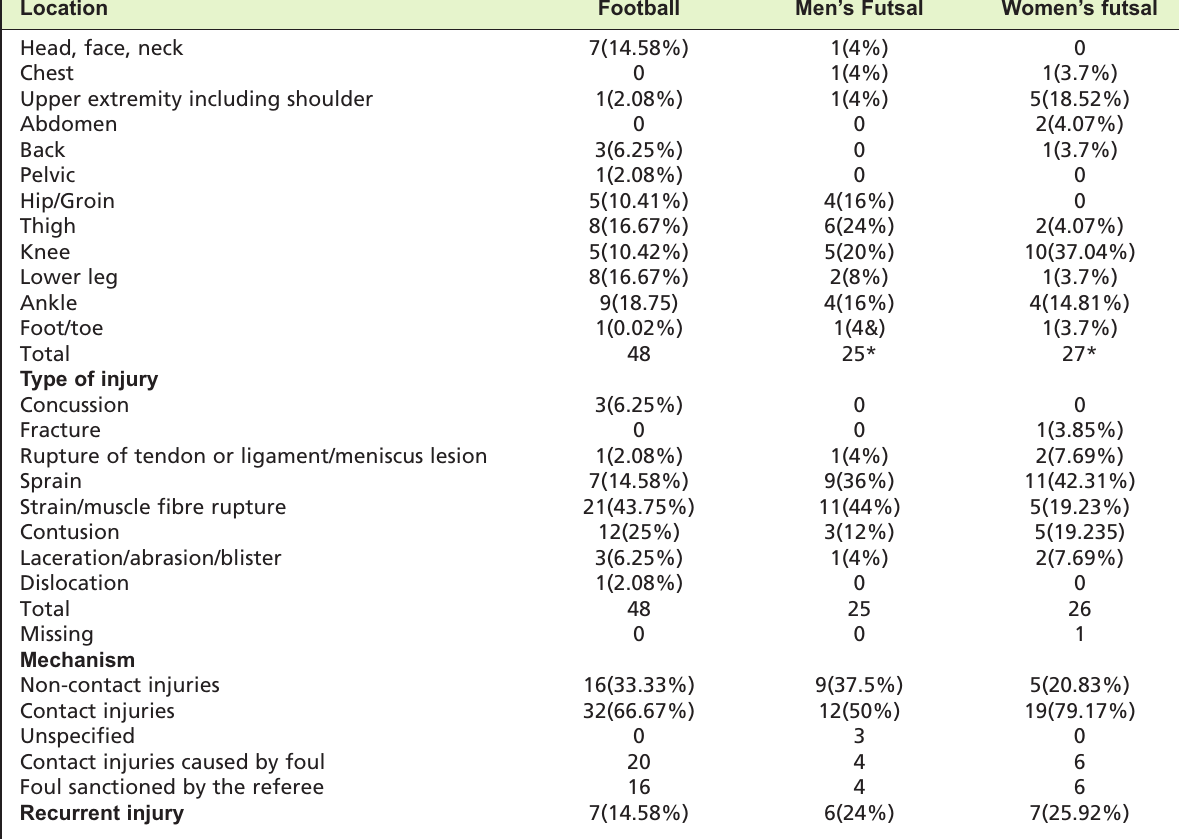
Location, type and mechanism of injury in football and Table III: